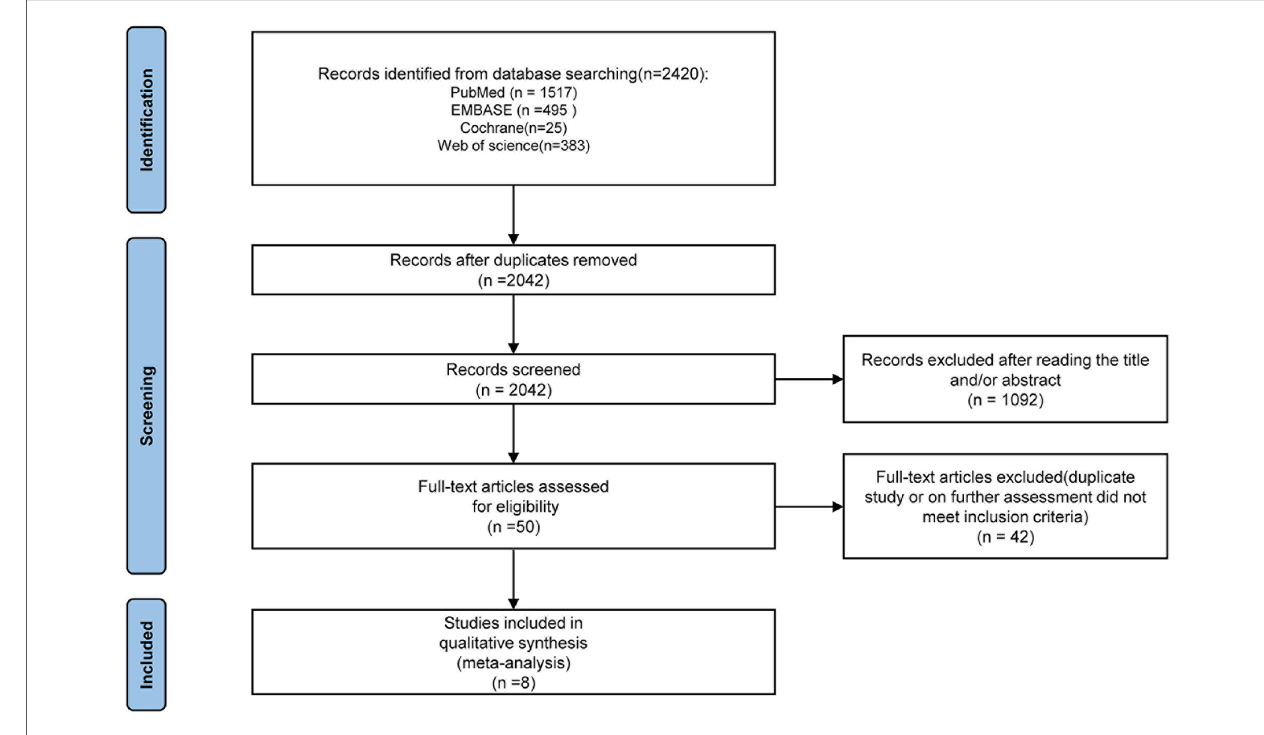
FIGURE 1 Flow chart illustrating summary of literature search results.